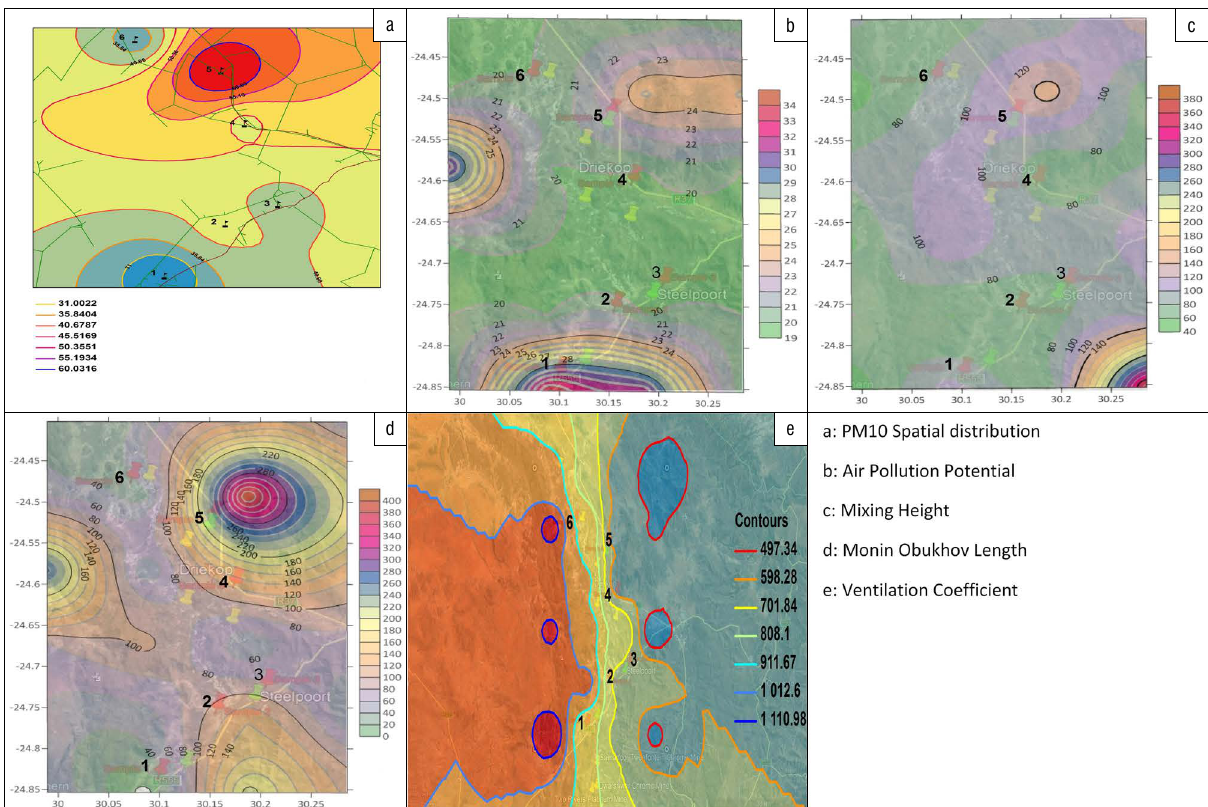
concentrations in winter. 10